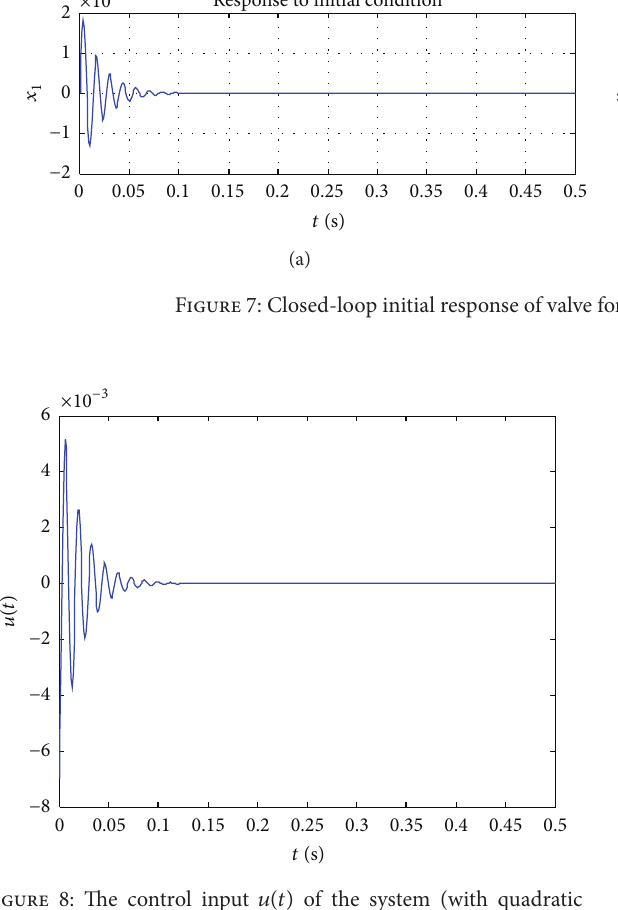
Figure 8: The control input 𝑢(𝑡) of the system (with quadratic